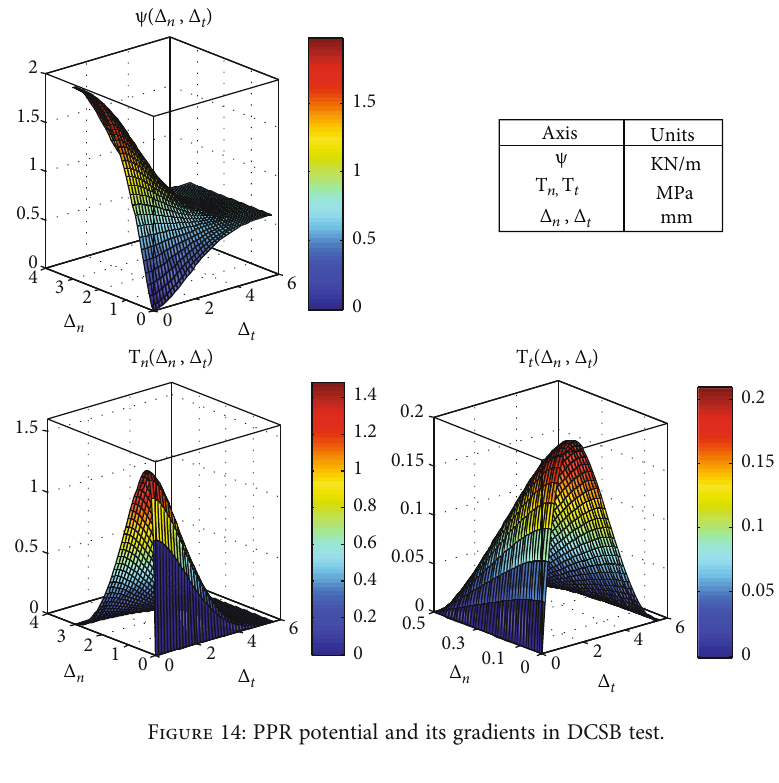
Figure 14: PPR potential and its gradients in DCSB test.